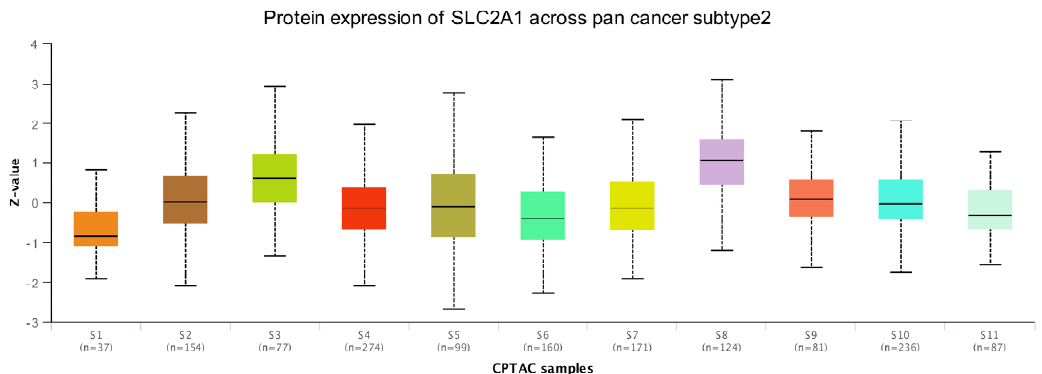
Figure 5. Protein expression of SLC2A1 across pan-cancer subtype in CPTAC samples based on UALCAN data.